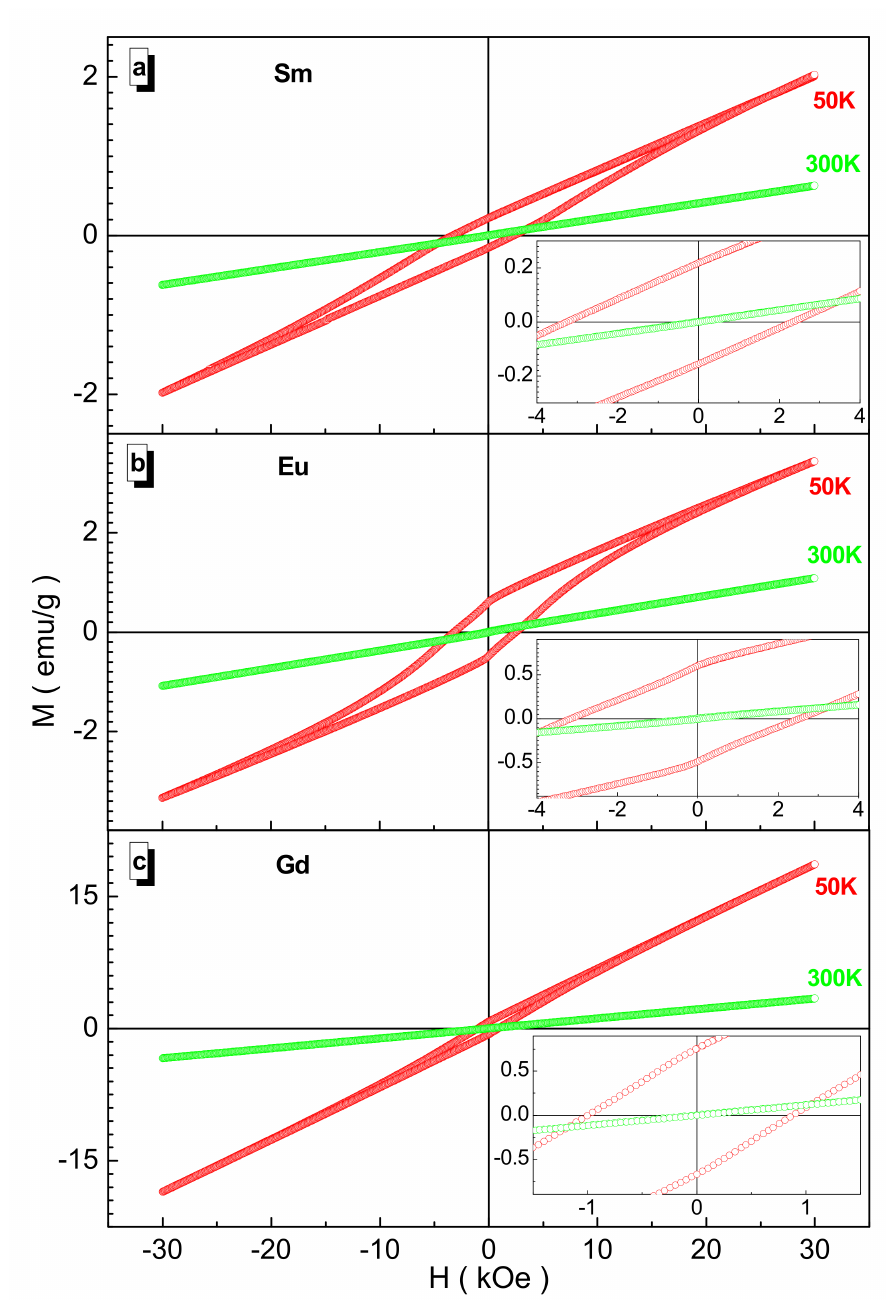
Figure 5. Field magnetization for the Sm- ( a ), Eu- ( b ), and Gd-based ( c ) samples at 50 K (red circle) and 300 K (green circle). Inset demonstrates the field magnetization on a larger